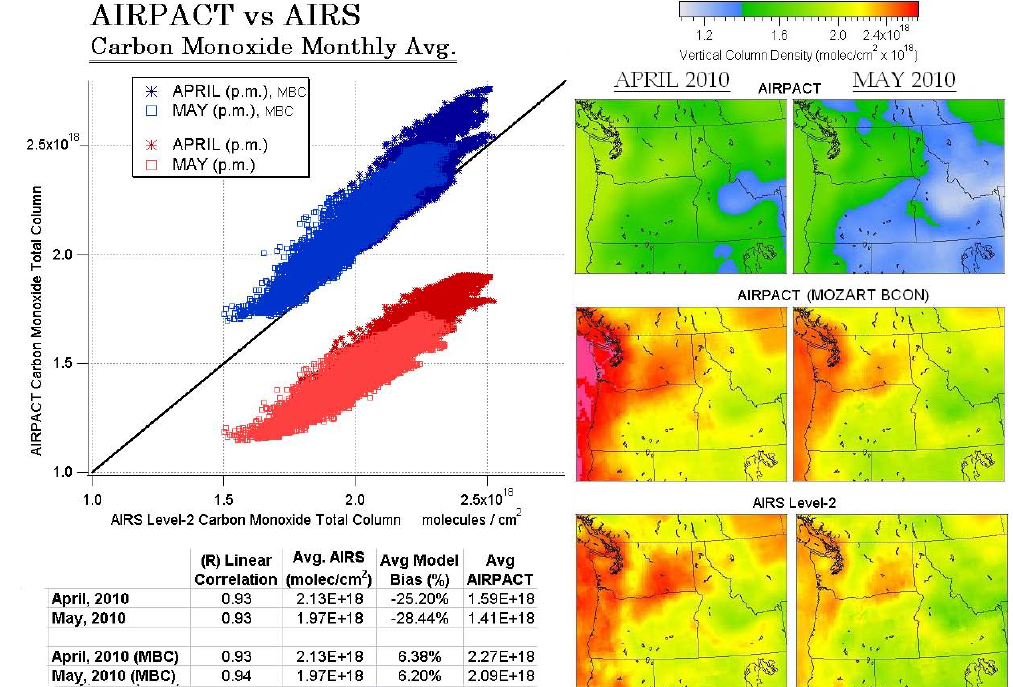
Fig. 6. Daytime ( ∼ 02:00 p.m. PST) carbon monoxide total column monthly averages for April and May of 2010. The linear correlation of AIRPACT-3 vs. AIRS CO is plotted (left) with original AIRPACT-3 in red and MOZART BCON-updated AIRPACT-3 in blue. Corresponding maps of the region (right) show the distribution of CO across the domain. Note: the AIRS averaging kernels have not been applied to the AIRPACT-3